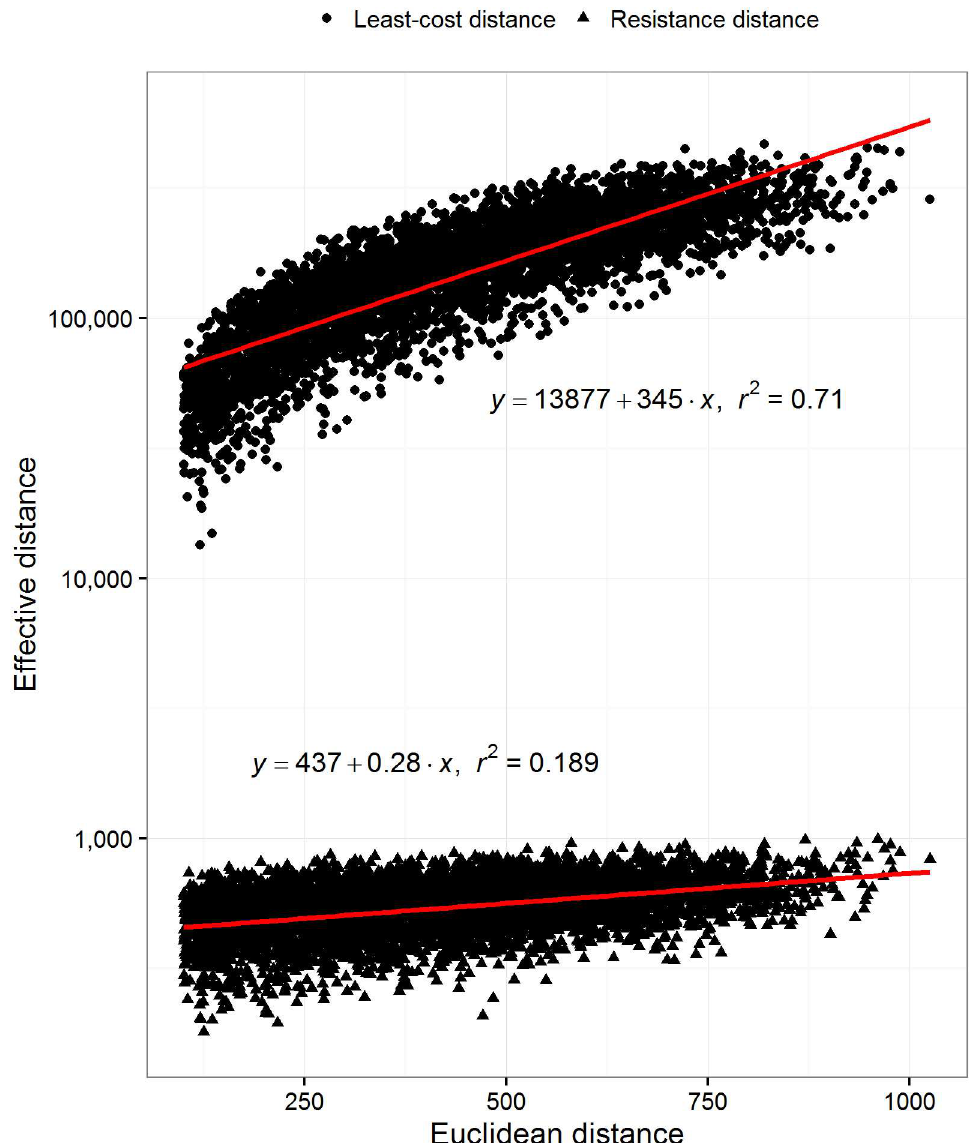
Fig 3. The effect of Euclidean distance. The effect of Euclideandistanceon both methods for a subset of 5,000 random paths sampledfrom 1000 different simulatedlandscapes representedwith 1 millionpixels or nodes. The y-axis in this graph is on a logarithmic scale for visualizationpurposes only. Least-cost distance increaseslinearlywith Euclidean distancewhile resistancedistanceincreaseslinearlyto quite a lesser extent. Landscapesize (number of pixels) is held constant at